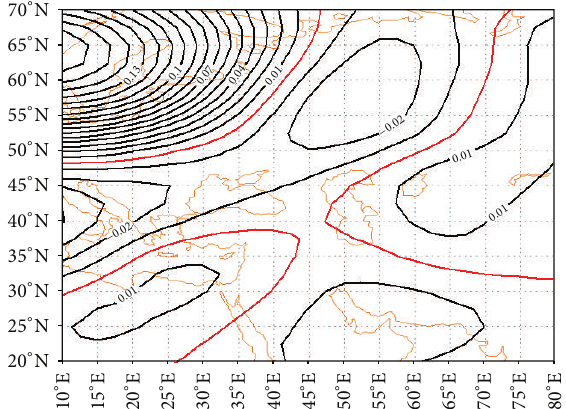
Figure 3: The second component of 500 HPa geopotential height level